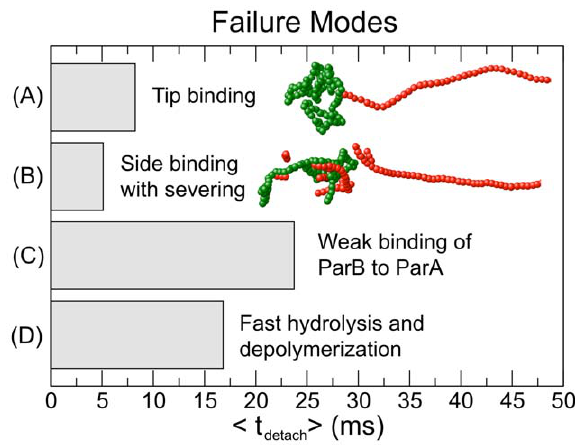
Figure 2. Mean time, S t detach T , to first detachment of ParB polymer from ParA for various failure modes. In a standard simulation, ParB binds ParA filaments side-on, and hydrolyzes individual ParA subunits. Hydrolyzed ParA disassembles from the tip of each filament in the bundle. In a typical simulation it takes about 200ms for the ParB polymer to translocate across a distance of 1 m m . However, ParB completely detaches in a short time if (A) the ParB polymer binds to only the tips of the ParA filaments or (B) if ParA filaments disassemble via mid-filament severing. In addition, the ParB polymer detaches if (C) ParB binds too weakly to ParA or (D) ParA disassembles too quickly. Measurements for (A) and (B) are taken from simulations with side- binding with severing or tip binding, respectively, with standard parameters. Measurements for (C) and (D) are taken from simulations with the slowest disassembly rate or highest binding energy, respectively, for which the mean time to first detachment is shorter than the time required for the ParB polymer to translocate across the cell. model, ParA filaments can disassemble by severing in addition to